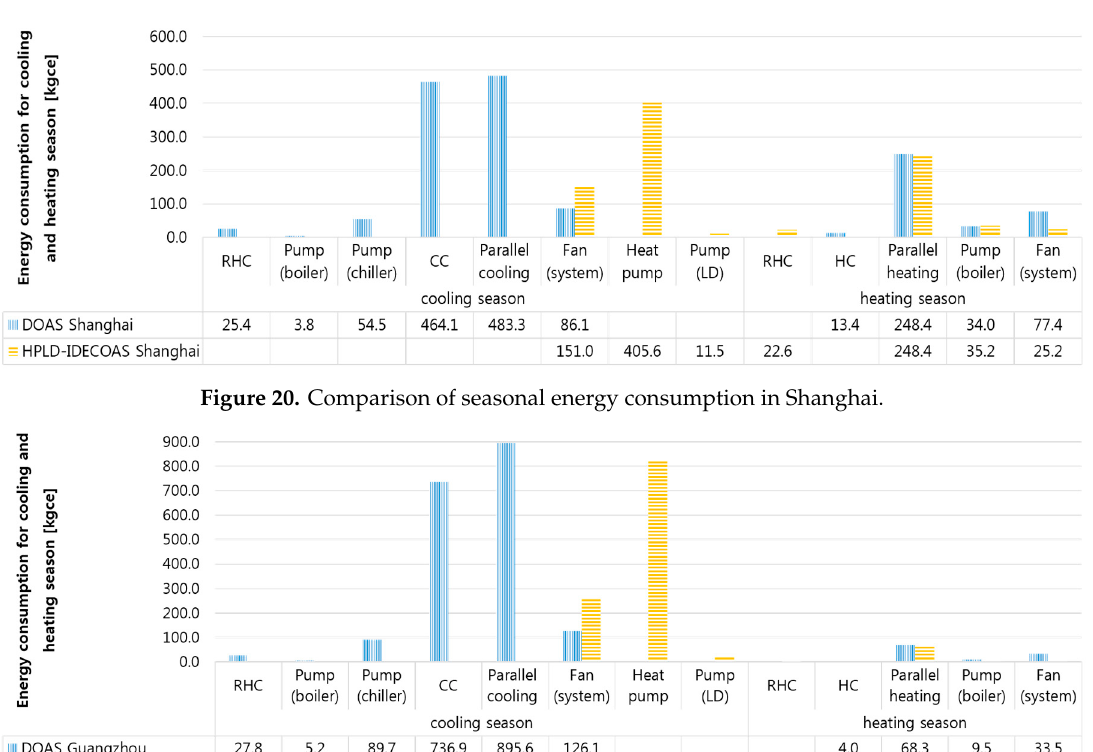
Figure 21. Comparison of seasonal energy consumption in Guangzhou.